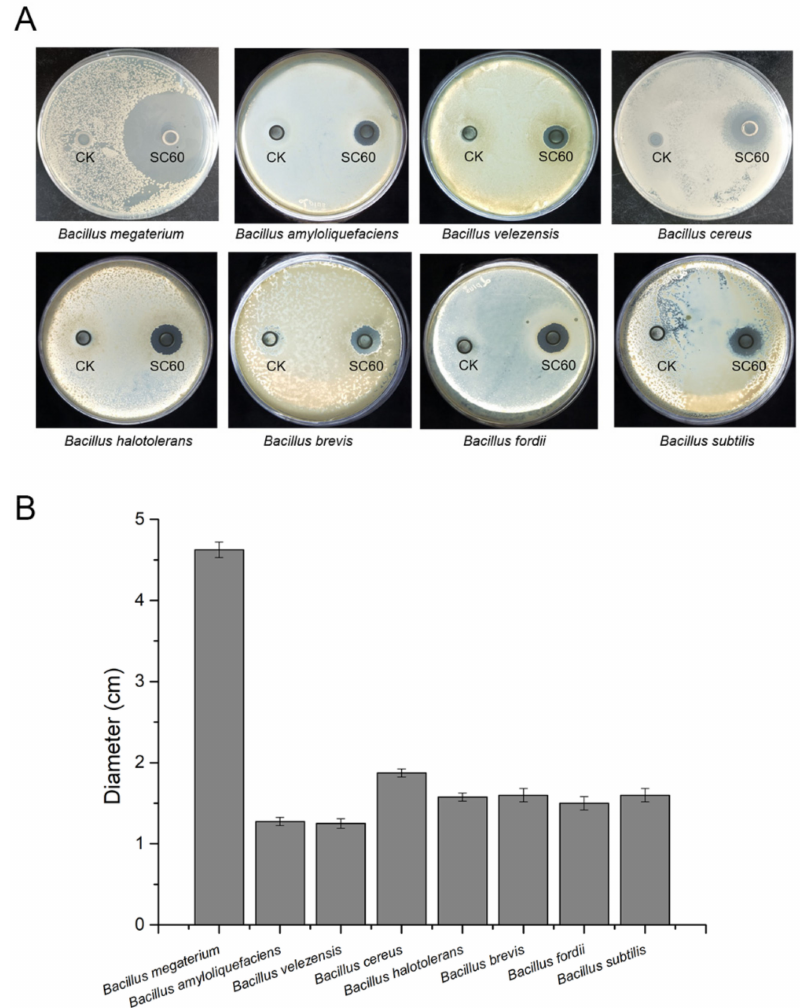
Figure 6. Antagonistic activity of strain SC60 against closely related Bacillus spp. ( A ) Inhibition effect of strain SC60 on the growth of Bacillus spp. ( B ) The diameter of the zone of inhibition. Error bars indicate the standard deviations based on four independently replicated